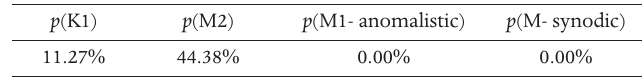
Table 4. The confidence levels of the earthquake–earth tide correlation for the 186 earthquakes events that occurred during January 1983 in the area of